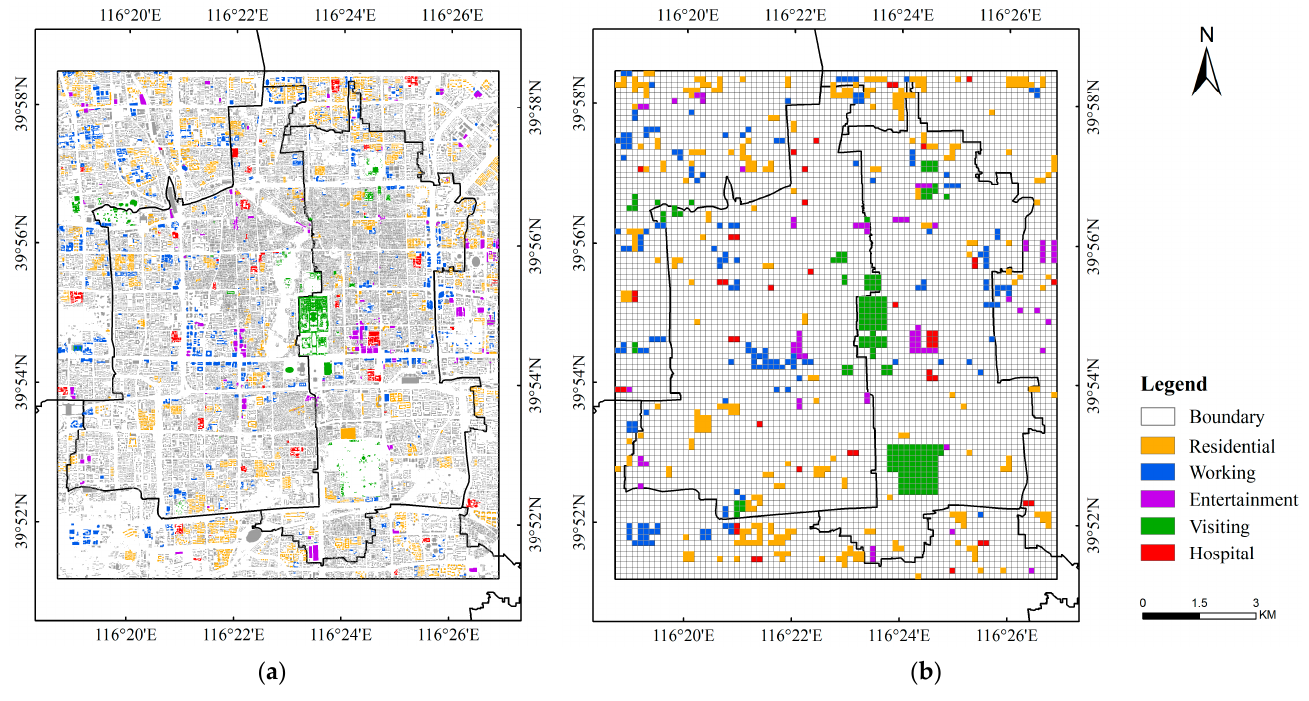
Figure 4. The distribution of building function type (BFT) samples used in this study according to OSM and Gaode classes: ( a ) Building level in vector format; ( b ) pixel level in raster format.